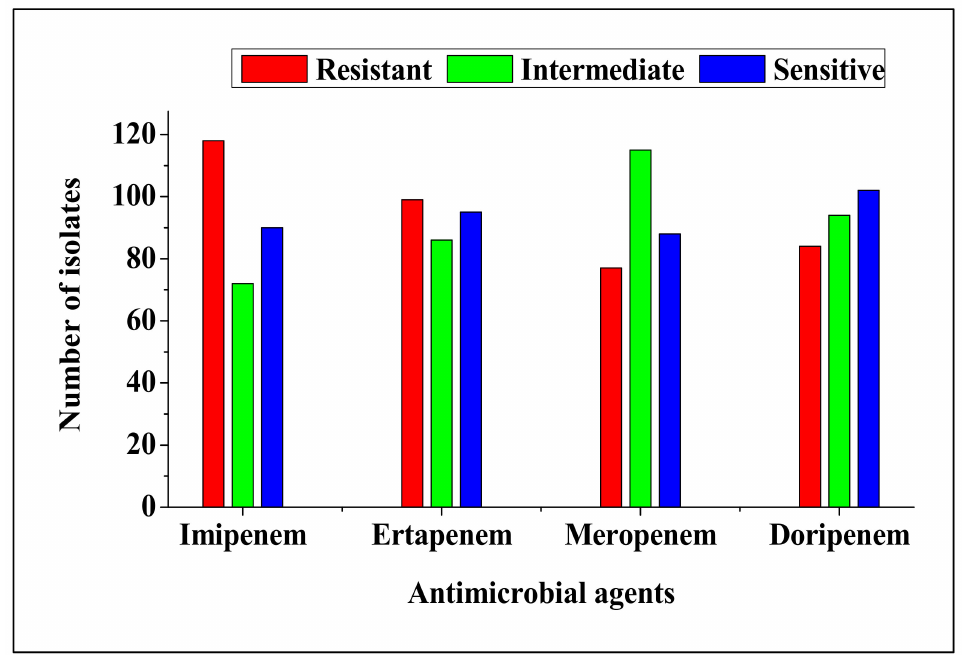
Figure 1. Antimicrobial susceptibility profile of Enterobacteriaceae isolated from cattle